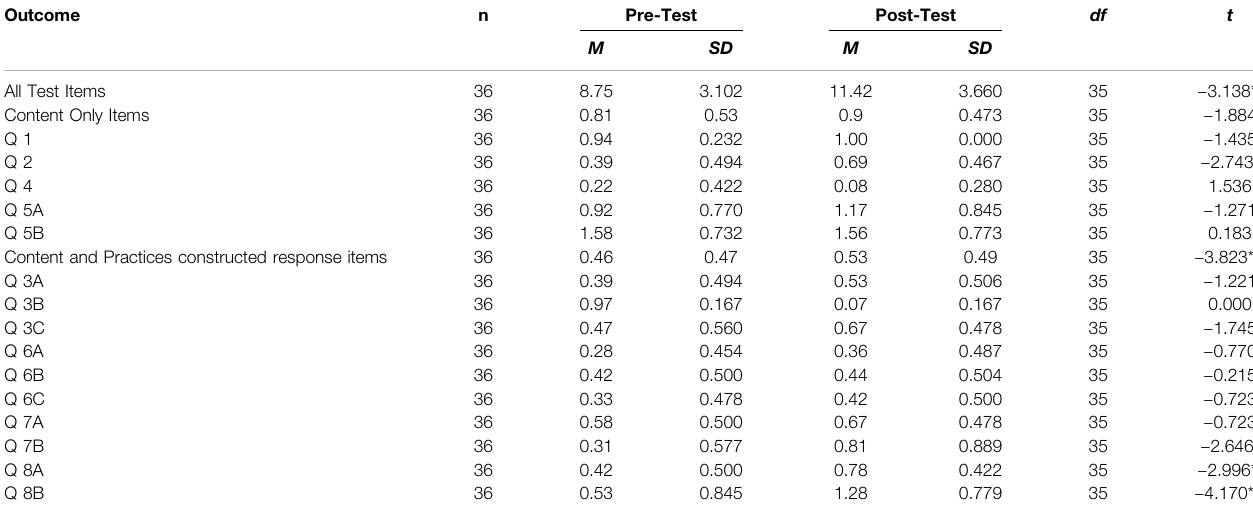
TABLE 4 | Descriptive Statistics and t -test Results for Pre and Post Tests (Cycle 1) Outcome n Pre-Test